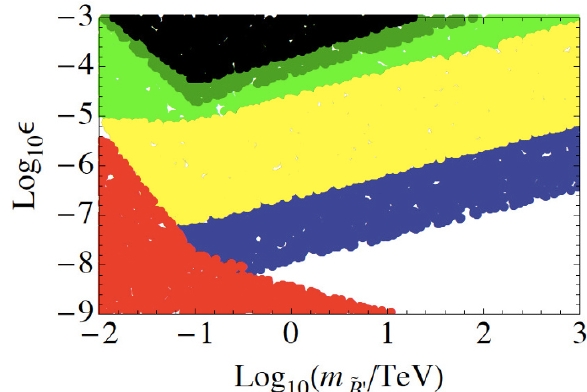
Figure 3 . Regions of parameter space where the desired amount of baryon asymmetry can be produced from cosmological histories where the ~ B 0 freezes out (green, yellow) or freezes in (blue), for m 0 = max(1 TeV ; 10 m ~ ) ; m ~ = 0 : 3 m ~ ; and (cid:21) 00 = 0 : 1. In the green region, the ~ B 0 thermalizes B 0 B B 0 and freezes out via scattering processes ((cid:12)gure 2), whereas in the yellow region the ~ B 0 reaches equilibrium abundance by virtue of the decay process ~ f ! ~ B 0 f . Dark green and black points denote regions where the washout processes (baryon number violating inverse decay and/or annihilation) are faster than Hubble at the time of ~ B 0 decay; in the dark green regions, a su(cid:14)cient amount of baryon asymmetry survives despite partial washout, while in the black region the observed baryon asymmetry in the Universe cannot be matched. Red region denotes parameter space where the ~ B 0 decay occurs after BBN ( T = 1